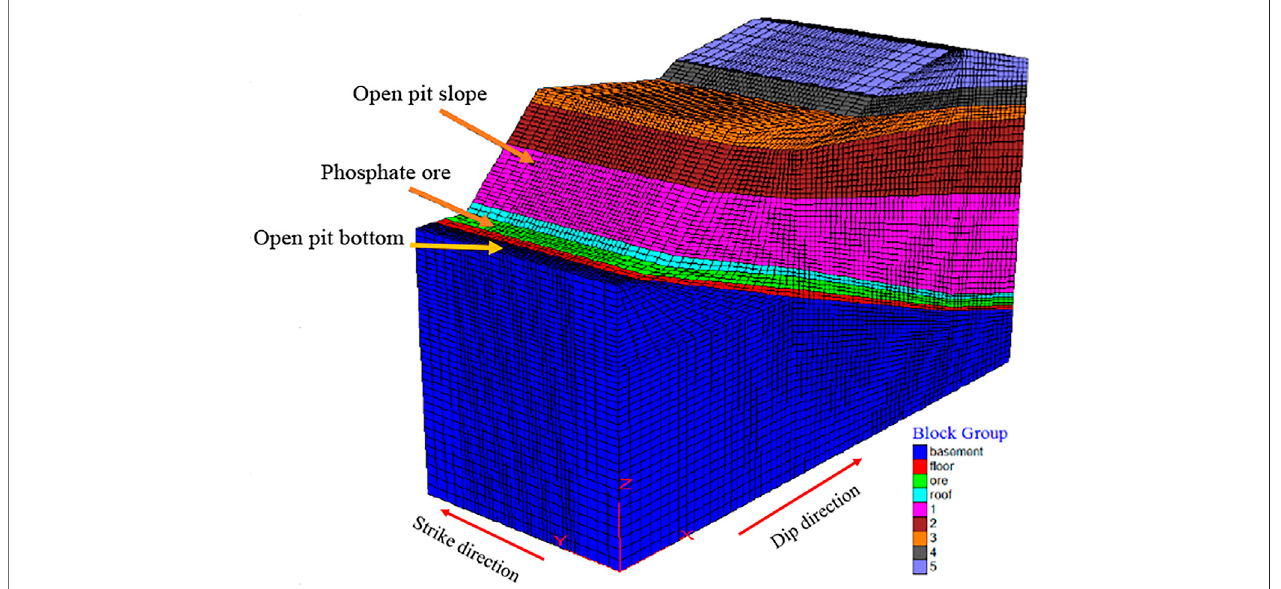
FIGURE 1 | Diagram of the numerical